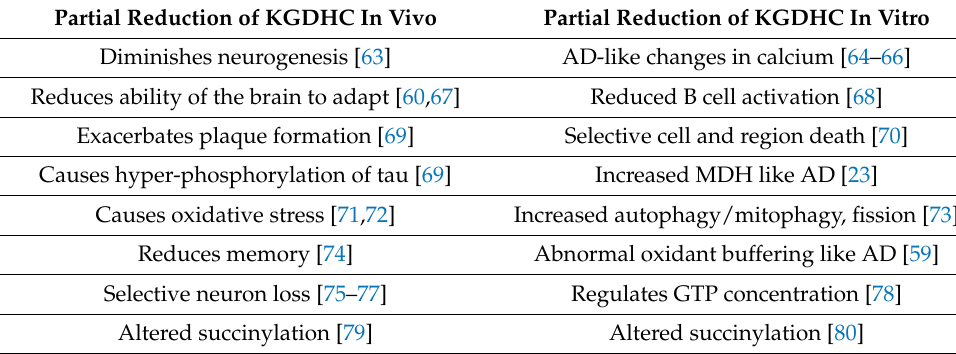
Table 2. Summary of primary changes caused by partial reduction of